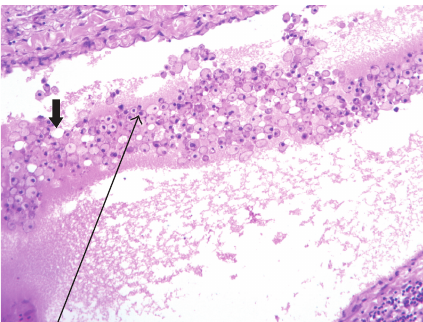
Figure 4: H&E stain (low magnification). Diffuse sheets of foamy macrophages (long arrow) admixed with chylous spaces (short arrow) H&E × 40.